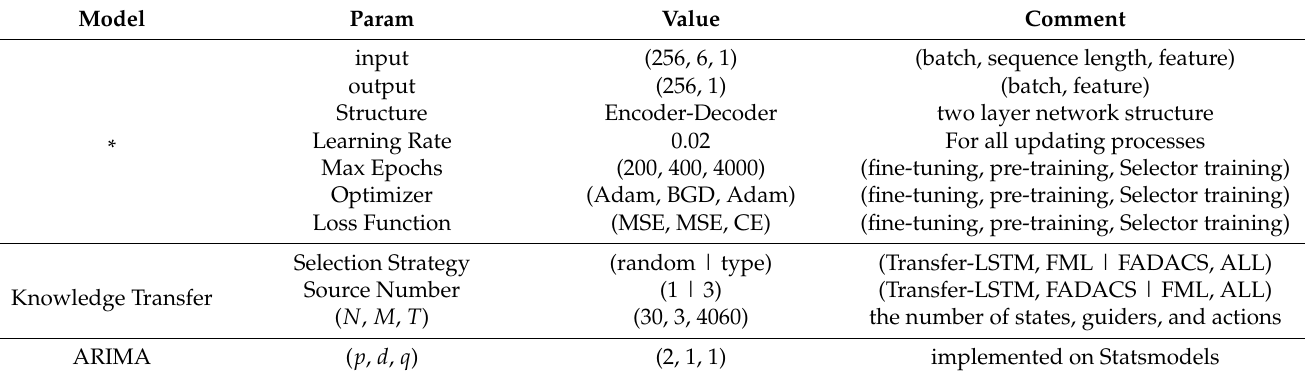
Table 4. Running